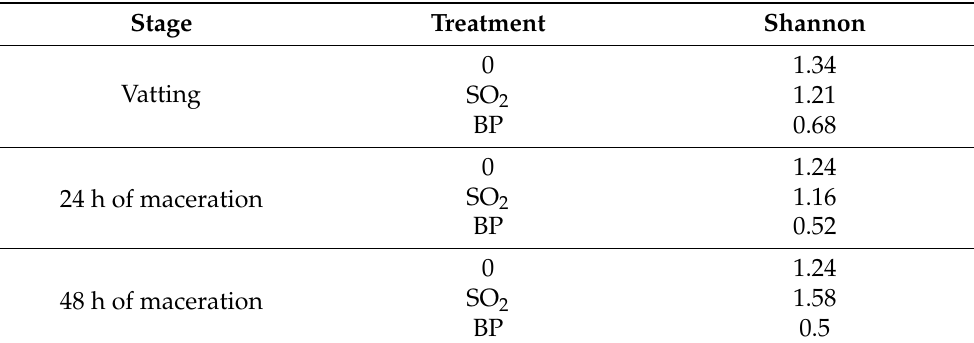
Table 3. Shannon index evaluated by MALDI-TOF